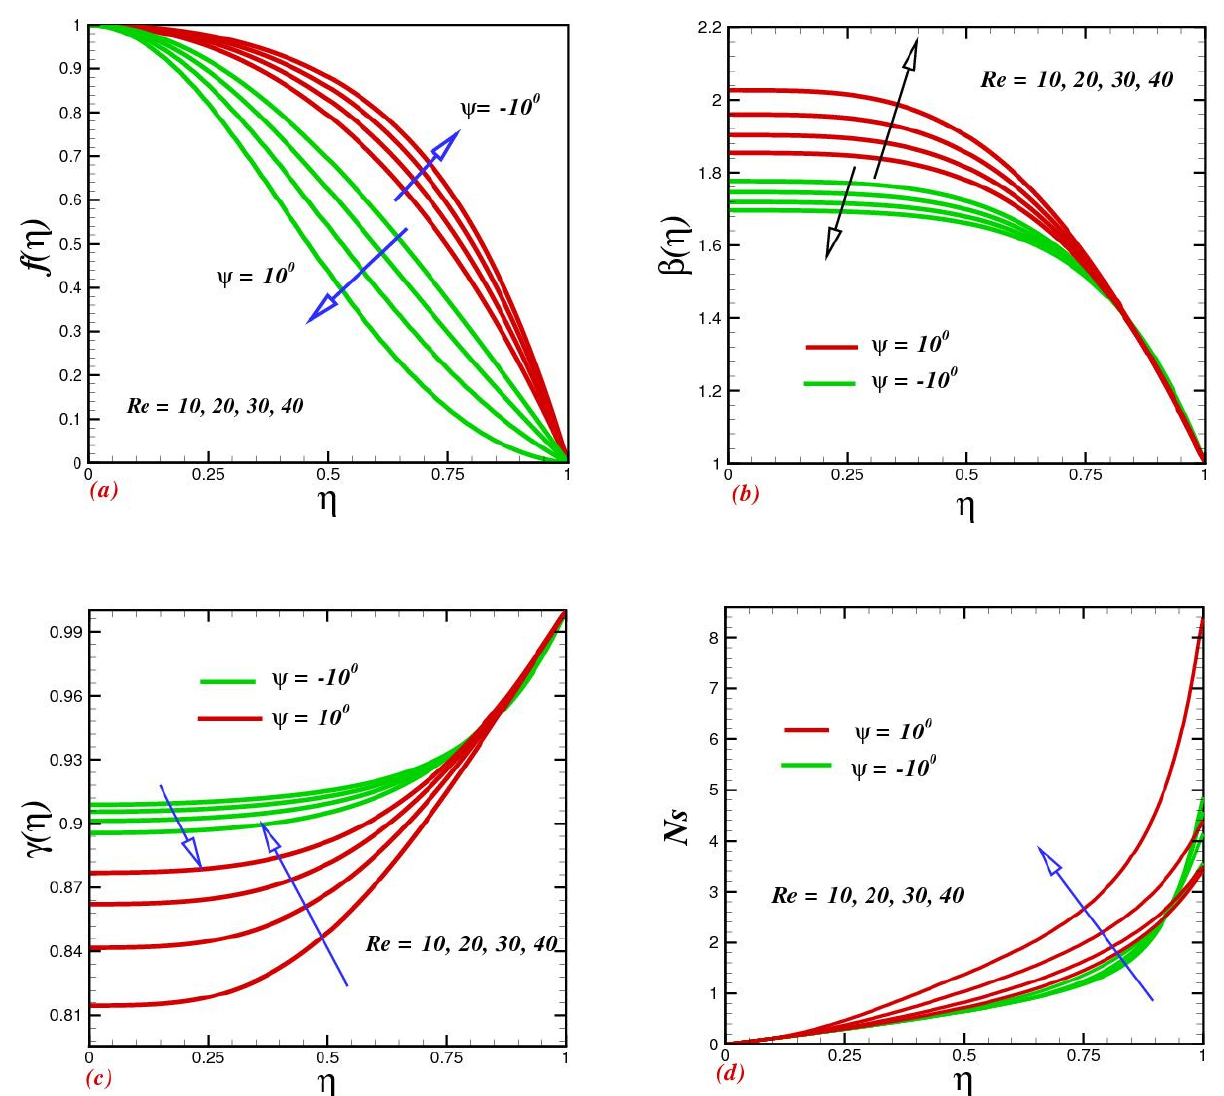
Figure 2. Impacts of the Reynolds number Re on ( a ) velocity f ( η ) , ( b ) temperature β ( η ) , ( c ) concentration γ ( η ) , and ( d ) entropy production Ns